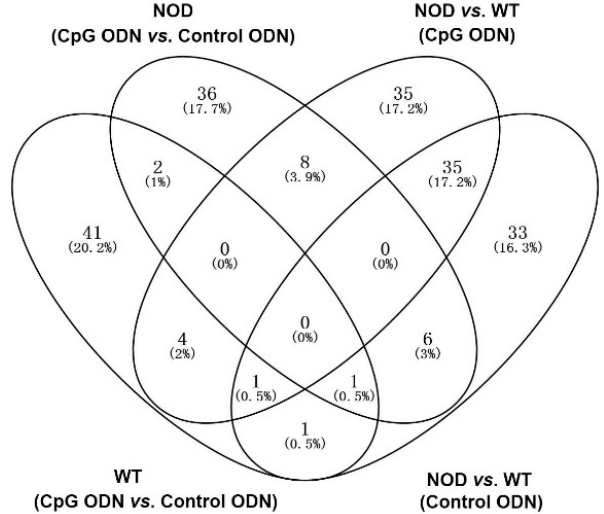
Figure 1. Unique or shared differentially expressed genes (DEGs). WT (CpG ODN vs. control ODN) refers to the DEGs between CpG ODN and control ODN-treated wild-type (WT) mice. NOD (CpG ODN vs. control ODN) refers to the DEGs between CpG ODN and control ODN-treated non-obese diabetic (NOD) mice. NOD vs. WT (CpG ODN) refers to the DEGs between WT and NOD mice with CpG ODN treatment. NOD vs. WT (Control ODN) refers to the DEGs between WT and NOD mice with control ODN treatment. Numbers of DEGs in the indicated comparisons are shown in the Venn diagram. The percentage numbers indicate the proportion of unique or shared DEGs to total DEGs.